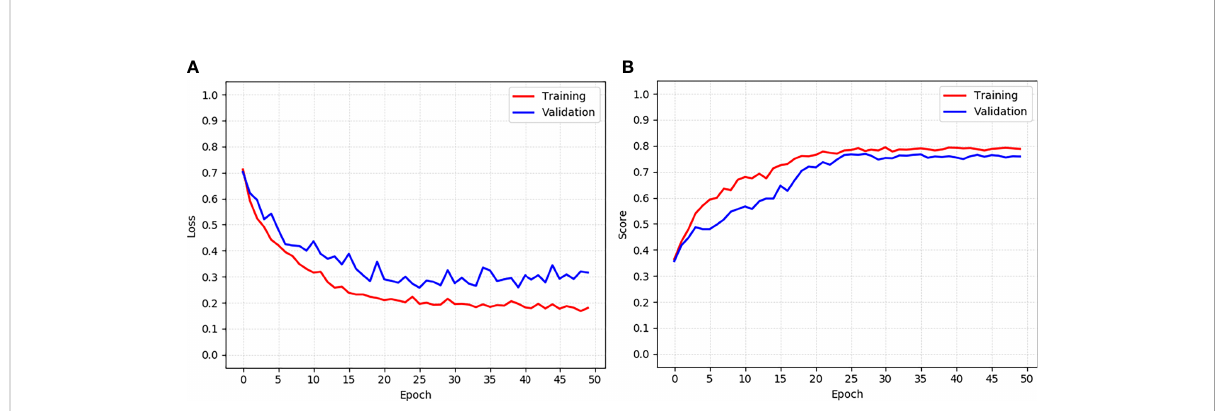
FIGURE 4 The training and validation loss and score curve of the CLS-Net. (A) Loss curve. (B) Score curve.